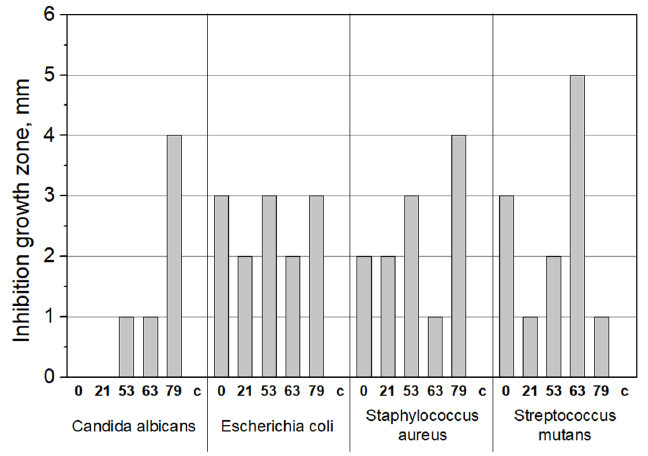
Figure 9. Growth inhibition zones of the bacterial strains in presence of the Zr–C coated samples.